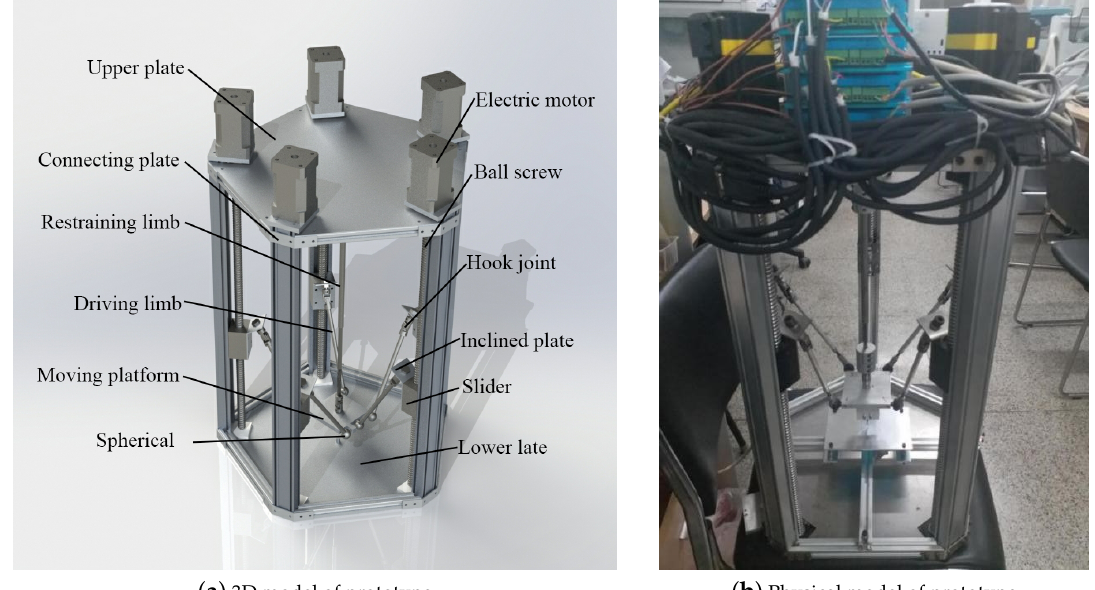
Figure 19. Prototype of parallel